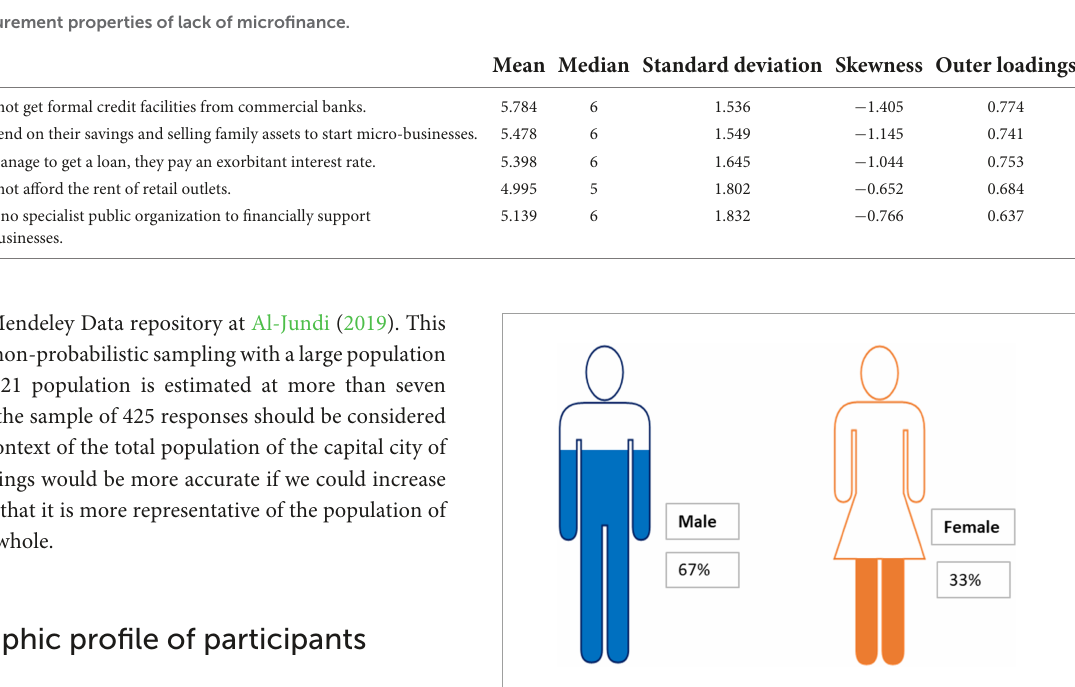
FIGURE2 Gender distribution of the 425